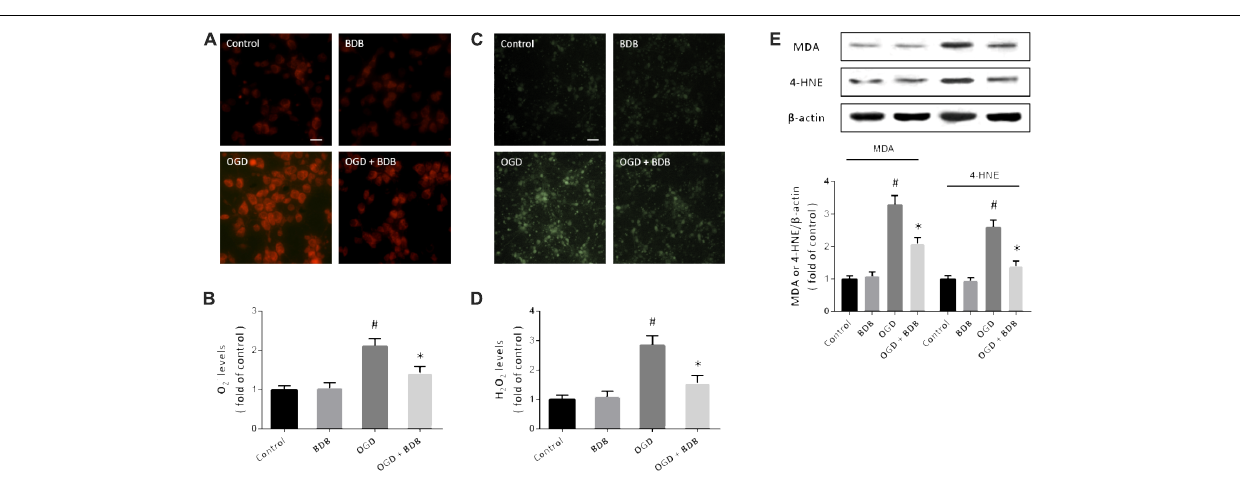
FIGURE 2 | BDB reduces oxidative stress after ischemia. (A,B) DHE staining (A) and quantification (B) show that BDB reduced the increase in O 2 − levels induced by OGD. (C,D) DCFH-DA staining (C) and quantification (D) show that BDB reduced H 2 O 2 levels induced by OGD. (E) Western blot shows that BDB attenuated lipid peroxidation induced by OGD. Scale bar, 20 µ m. Data are shown as mean ± SEM ( n = 6). # p < 0.05 vs. Control. ∗ p < 0.05 vs.